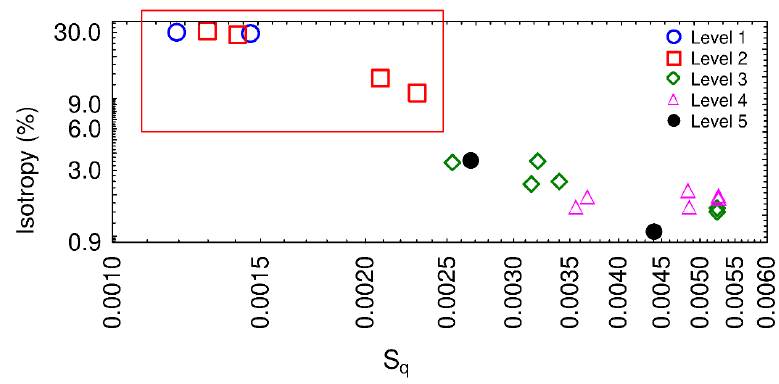
Figure 10. Isotropy as a function of the root-mean-square roughness S q computed for all the quarters of autocorrelation function.